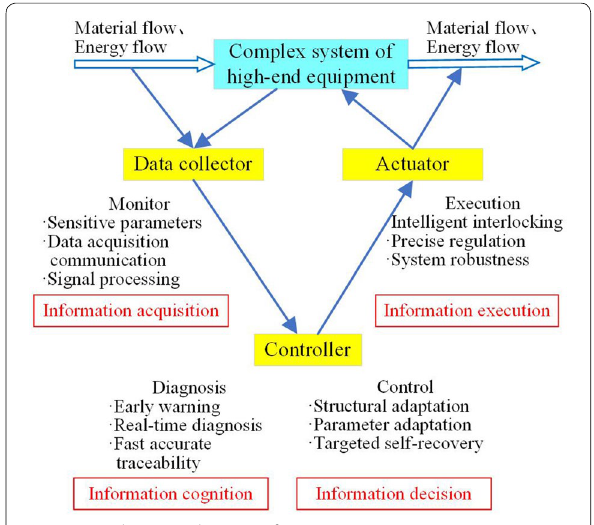
Figure 1 Schematic diagram of FSR